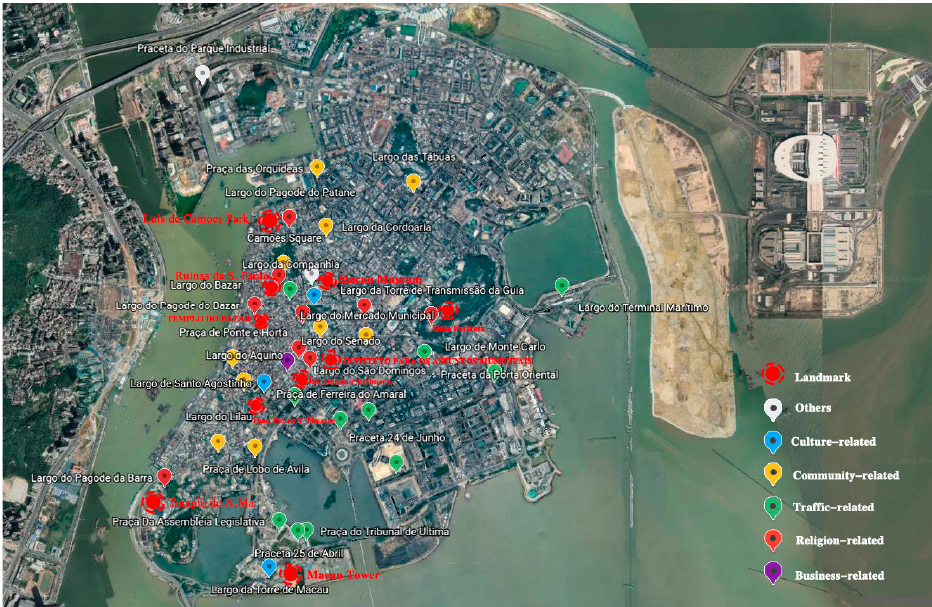
Figure 2. Lists of roads in Macau in 1867, 1906 and 1925.